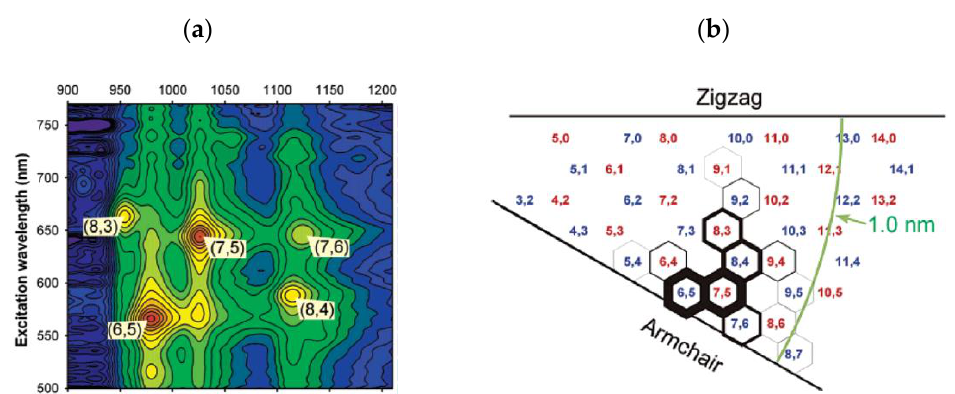
Figure 2. ( a ) Normalized 2D fluorescence map of excitation and emission wavelength of a chirality- enriched SWCNT sample. ( b ) Intensity distribution for all semiconducting (n,m) in the same sample. The edge thickness of the hexagons is proportional to the observed intensity for the (n,m) chirality [46]. Copyright 2010, American Chemical Society.